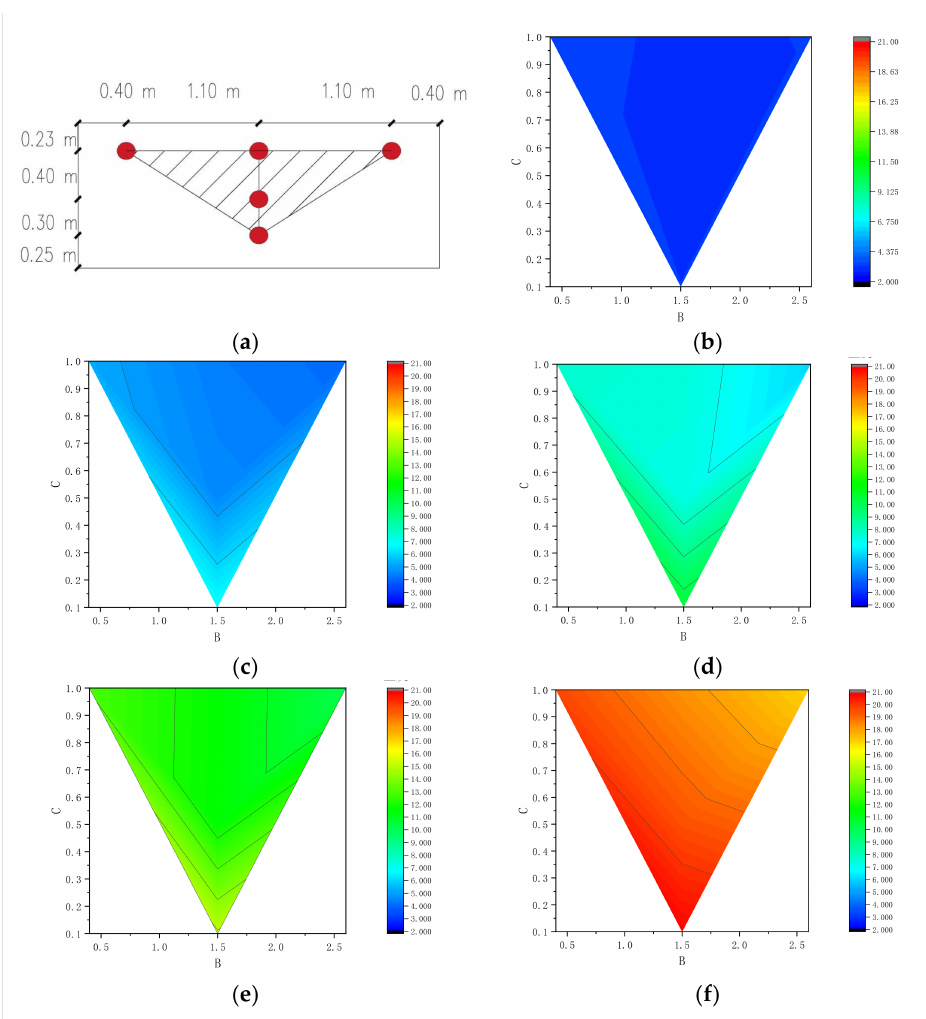
Figure 12. Cross distribution map of morning the sunspace’s thermal environment on 28 January; ( a ) Attached sunspace’s cross section of temperature field; ( b ) Distribution of temperature field at 8:30; ( c ) Distribution of temperature field at 9:00; ( d ) Distribution of temperature field at 9:30; ( e ) Distribution of temperature field at 10:00; ( f ) Distribution of temperature field at